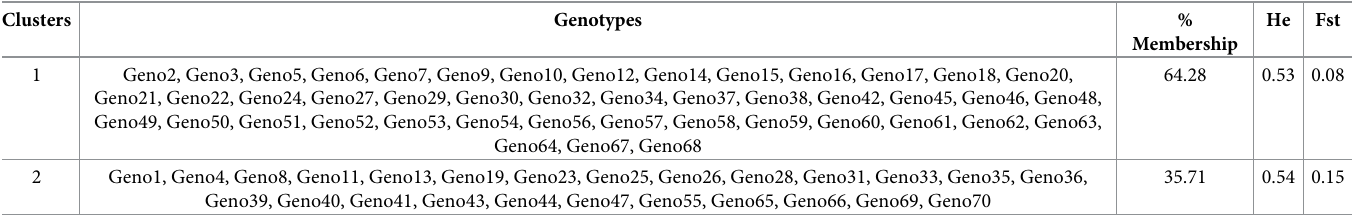
Table 8. Genetic clusters and member of genotypes observed from population structure analysis of 70 cowpea genotypes.